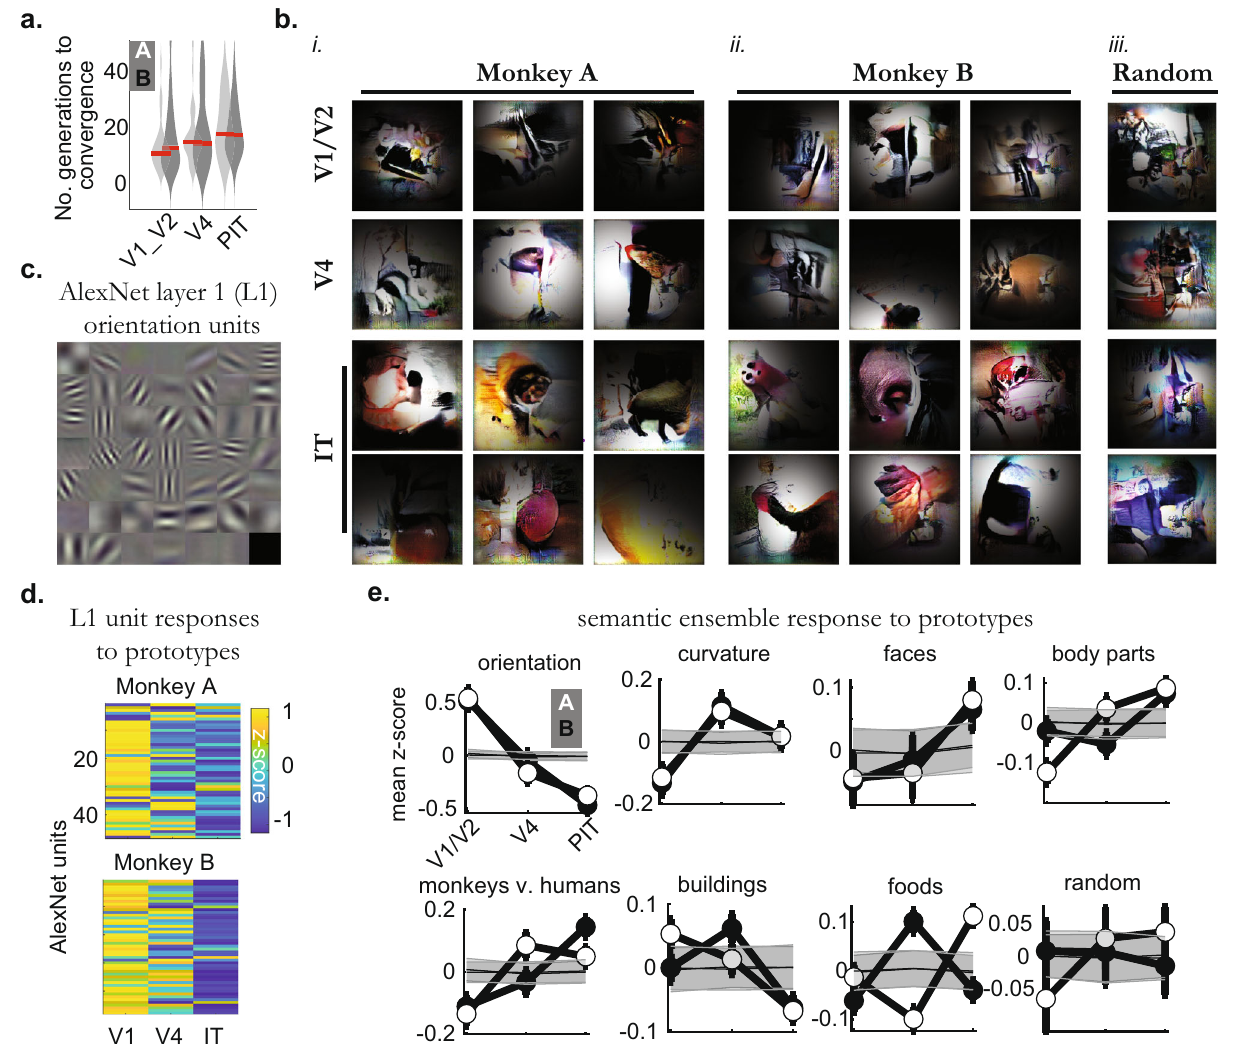
Fig. 2 Prototype development and interpretability. a Number of generations needed to reach half of the fi nal mean rate, as a function of the cortical region for both animals (A, B, black and white; red line: median, n = individual experiments per region, monkey A, V1/V2, 29; V4, 28; IT, 70; monkey B, V1/V2; 35, V4; 30 IT, 60). b Example synthetic images per monkey ( i-ii ) and visual area (rows), as well as examples of images synthesized during control random drift experiments (lacking neuronal guidance, iii ). Masks show estimates of each site ’ s receptive fi eld center. c Semantic ensemble for black-white contours consisting of 48 fi lters in AlexNet convolutional layer 1 (L1). d Mean activation levels of L1 units to all prototypes extracted from V1/V2, V4, and IT, per monkey. Colors represent the z-score across units and layers per monkey. e Different semantic ensemble responses to the extracted prototypes (black, monkey B, white, monkey A), using different populations of AlexNet fc6 units selected based on their responses to separate image sets (mean ± SEM; orientation, n = hidden units; orientation, 48; curvature, 249, faces, 33; body parts, 525; monkeys vs. humans, 309; buildings, 910; foods, 823; random, 200). Source data are provided as a Source Data fi